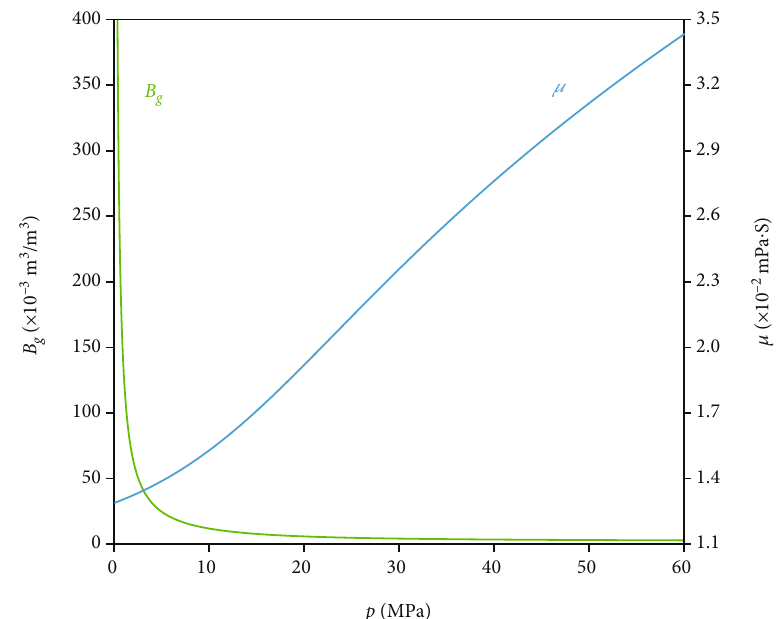
Figure 4: Gas formation volume factor ( B